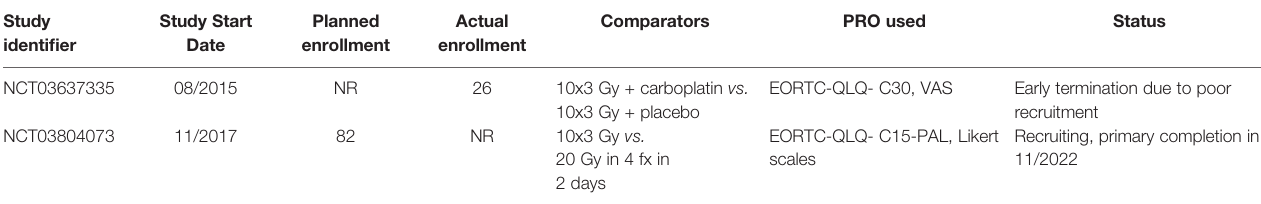
TABLE 4 | Studies registered on “ CinicalTrials.gov ” and not yet reported in November